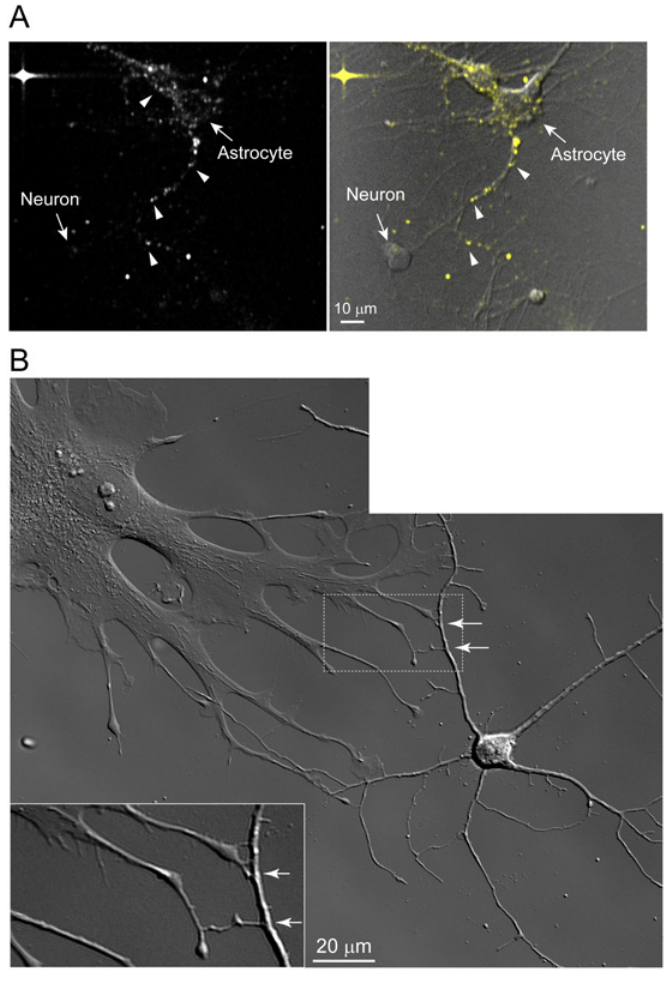
Fig 8. Astrocytes growing in neuron-enriched cultures efficiently internalize 263K A647 aggregates and produce long processes that often contact neurons. (A) Efficient internalization and dissemination of exogenous PrPres by primary astrocytes in neuron-enriched culture at 1 dpe. Astrocytes present within neuron-enriched cultures internalized PrPres at 1 dpe with similar efficiency to those grown in DMEM+. Vesicles carrying PrPres aggregates actively trafficked within the astrocyte processes. Neurons within the field of view appeared to make contact with PrPres-laden projections from astrocytes. Left panel, fluorescence channel. Right panel, merge of fluorescence and DIC channels. Arrowheads indicate 263K A647 particles in astrocyte cell bodies and projections. (B) Widefield DIC image of contact points between astrocytic projections and neurites. Some astrocytic projections appeared to be connected to neurites (arrows). Inset is a zoomed view of the dotted area.